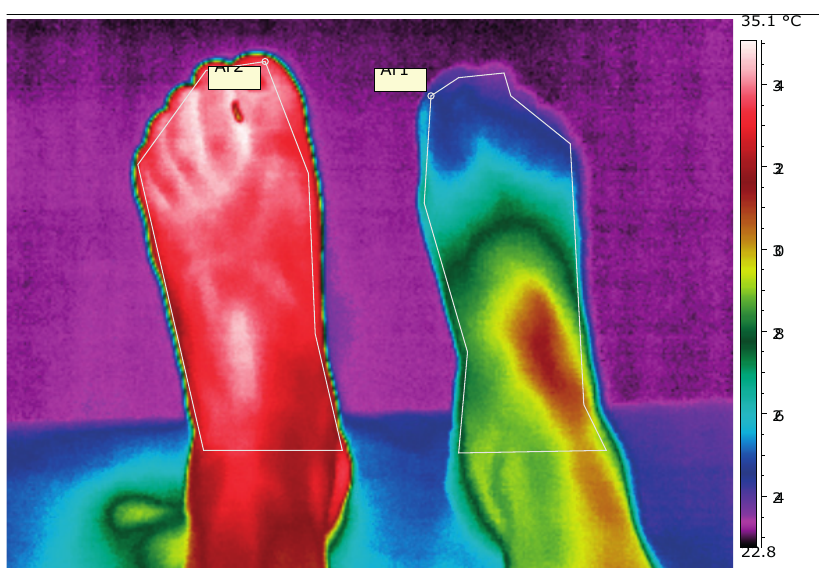
Fig. 1. Thermogram of the feet after ALIF L4/5, mean difference in temperature 5.8 °C. Female, 52 years